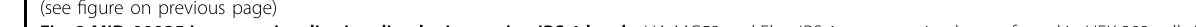
collected by tail cutting at each time point, and glucose levels were determined with an Accu-Chek Active gluc- ometer (Roche, Basel, Swiss).